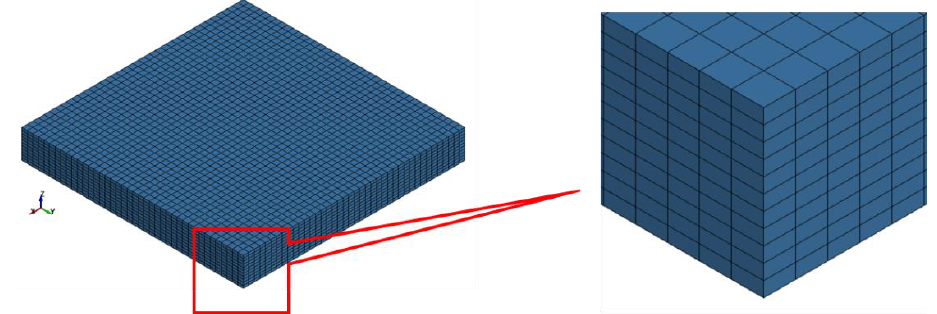
Figure 6 . A battery cell model with a homogeneous modelling technique . Figure 6. A battery cell model with a homogeneous modelling